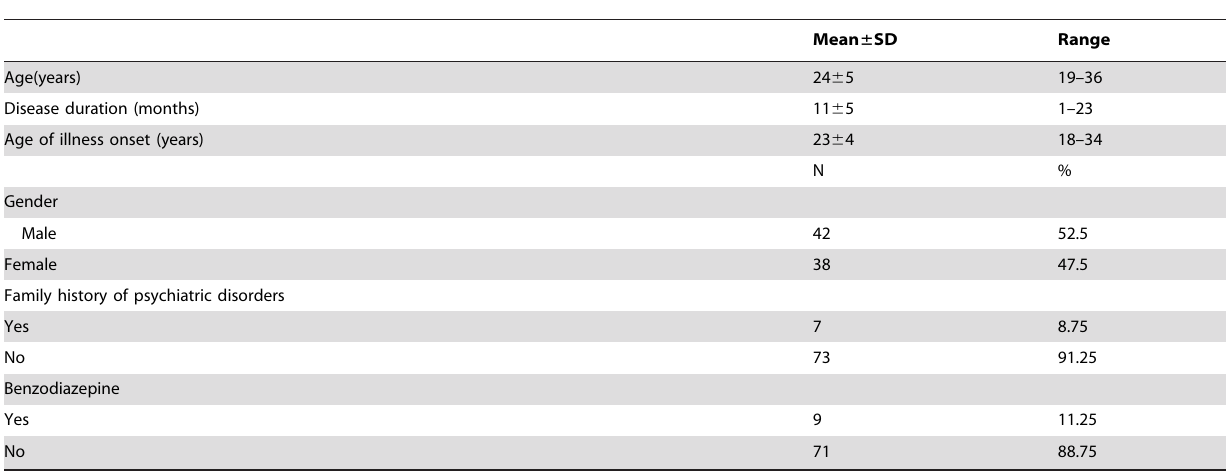
Table 1. Demographic characteristics of the study sample (N= 80).